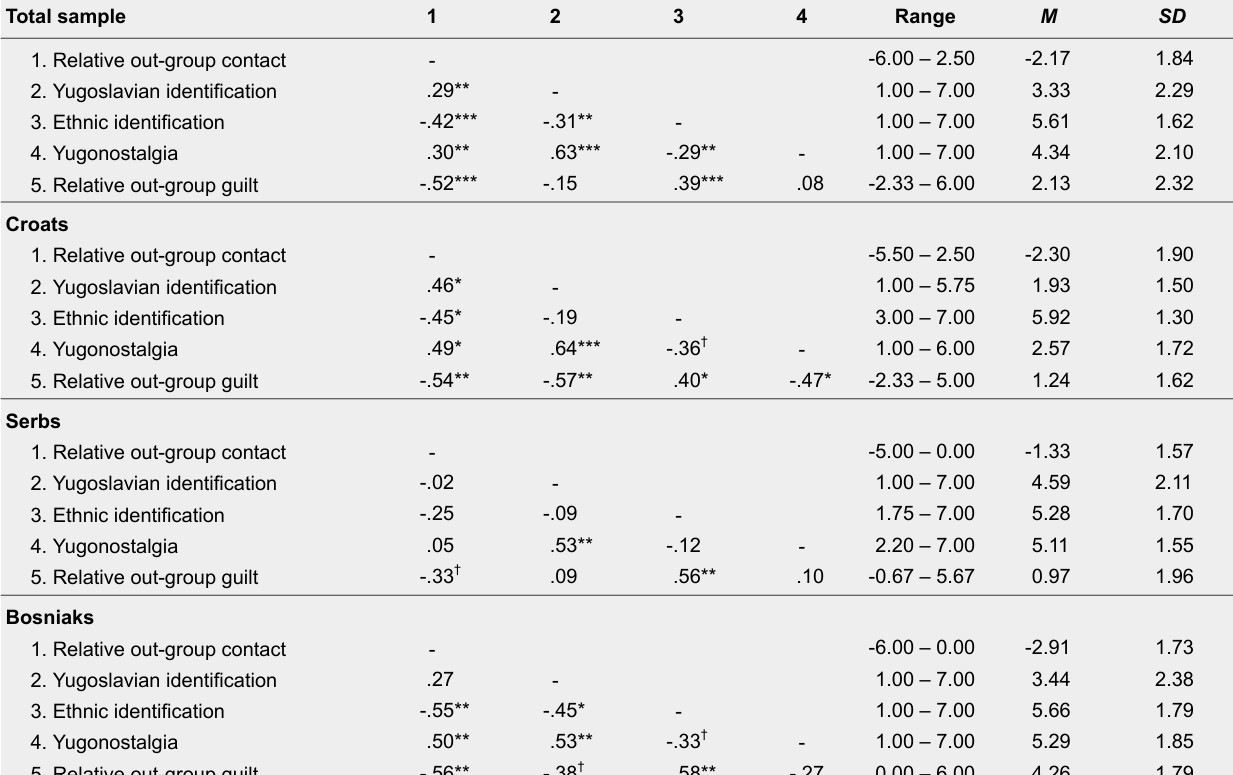
Descriptive Statistics of the Core Constructs: Total Sample and by Ethnic